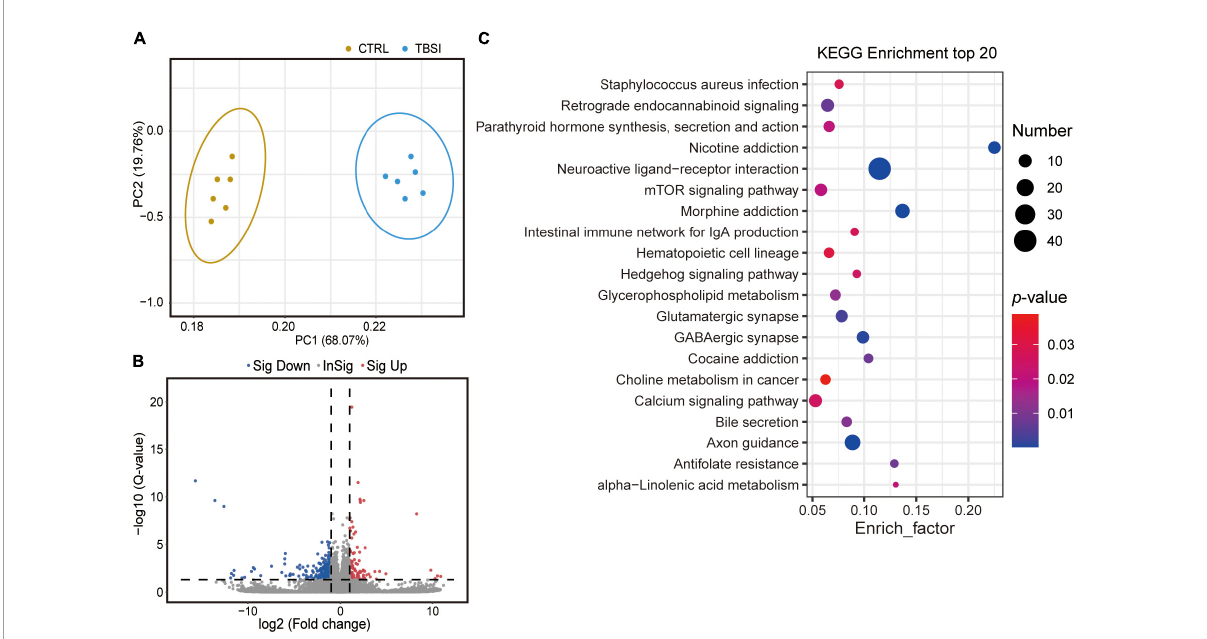
FIGURE3 Transcriptomic data analysis of rat brainstem. (A) Principal component analysis (PCA) of RNA-seq data. The dots represent biological replicates. (B) Volcano plot showing relative transcript abundance. Gray dots indicate no statistically significant differences in gene expression. Red dots represent up-regulated genes and blue dots represent statistically significant down-regulated genes. (C) KEGG pathway analysis of the top 20 outcomes of DEGs identified between the TBSI and CTRL